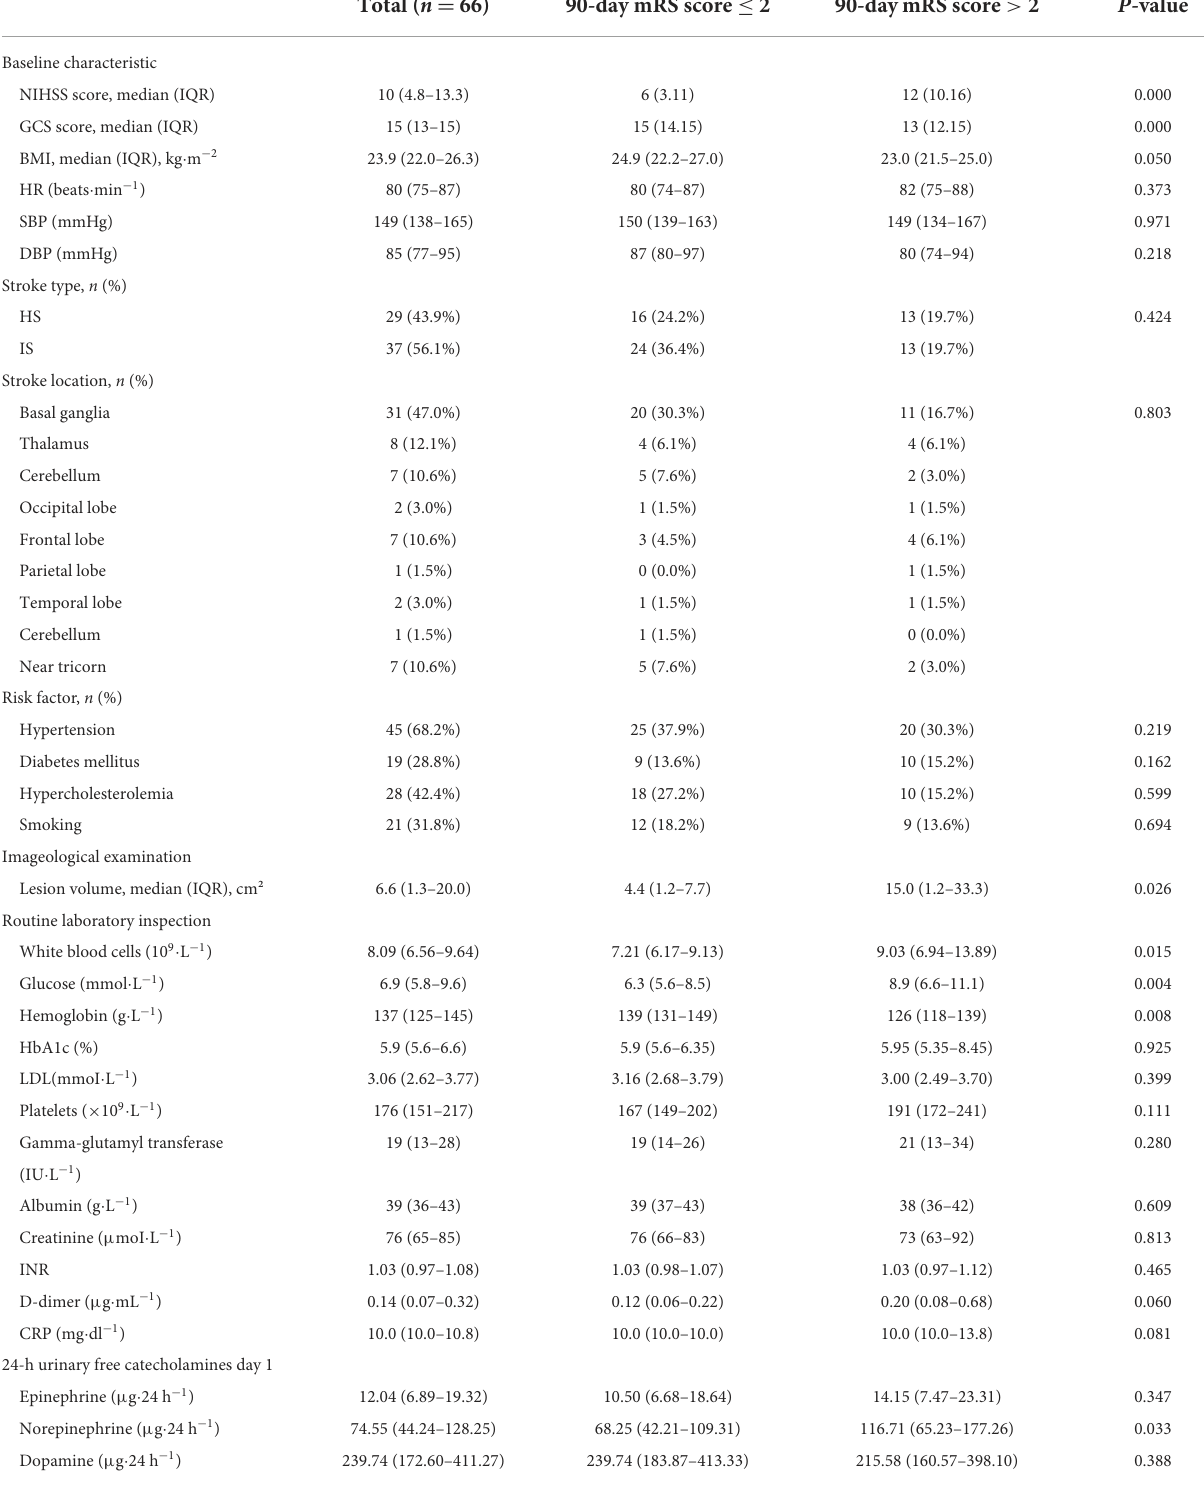
TABLE 2 Baseline characteristics of stroke patients on admission to